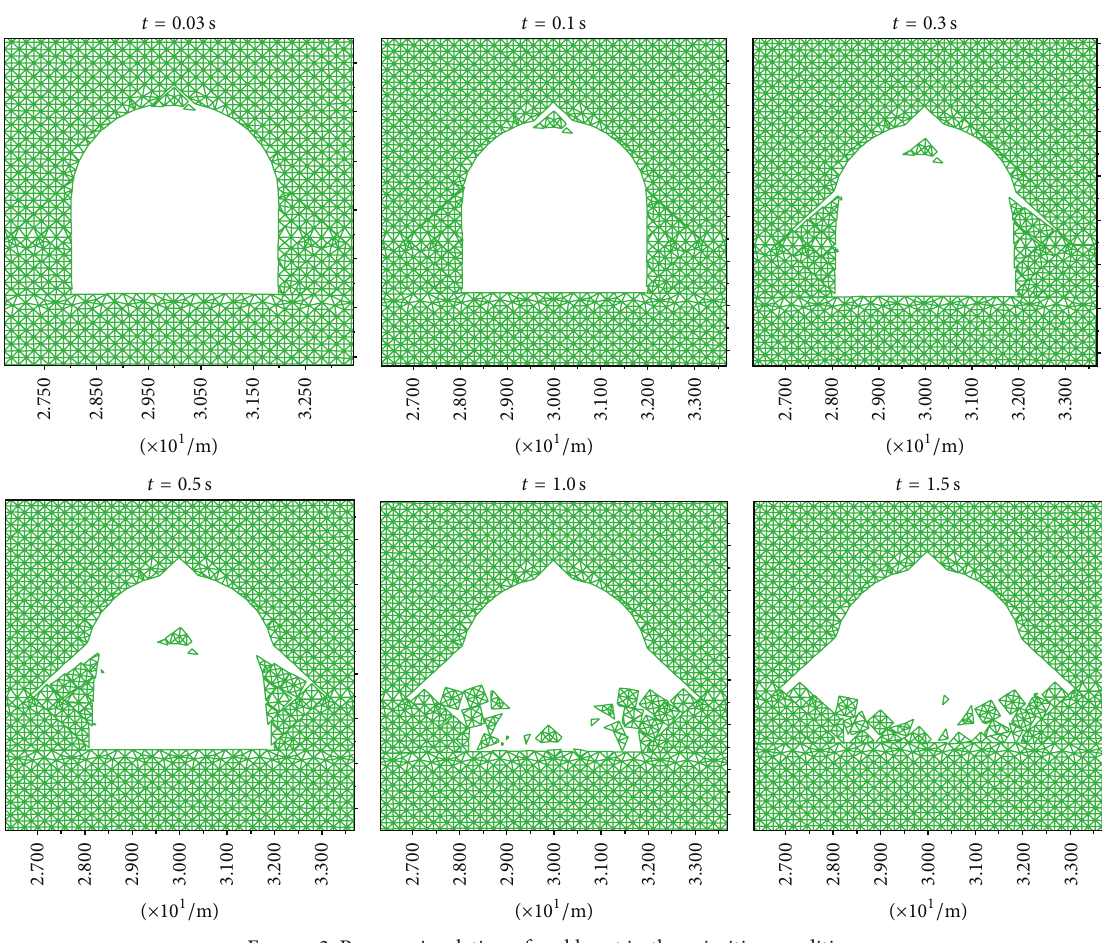
Figure 2: Process simulation of rockburst in the primitive